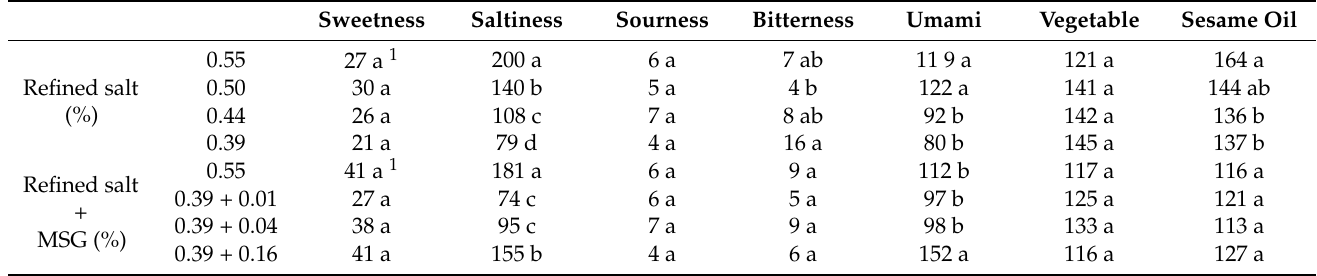
Table 3. RATA counts according to salt or salts with MSG concentrations for vegetable rice